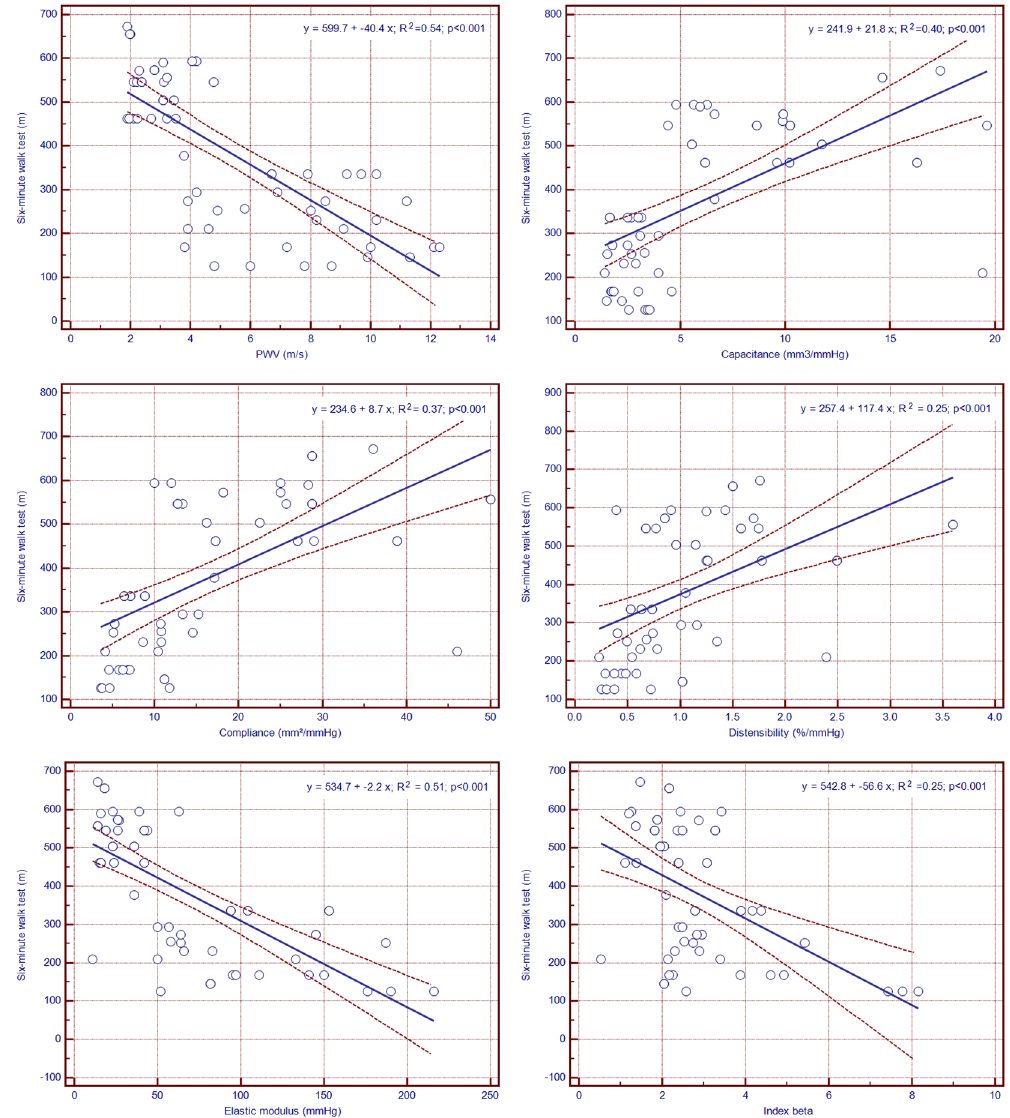
Figure 1. Scatter plots showing linear relationships between six-minute walk test distances and pulmonary artery stiffness